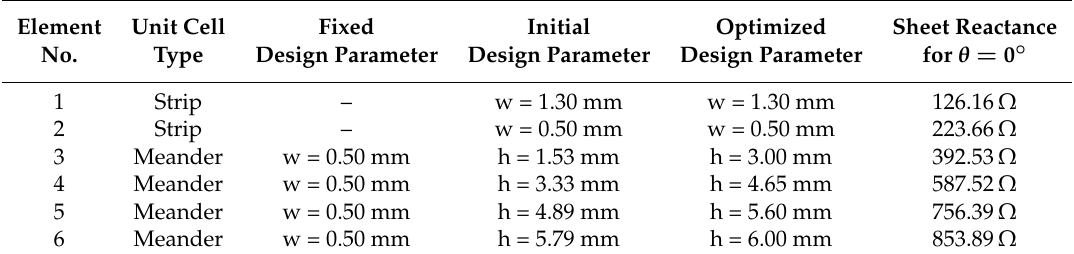
Table 1. Design parameters of a semi-cylindrical metasurface. Numeration starts at the φ = φ min edge of the structure.